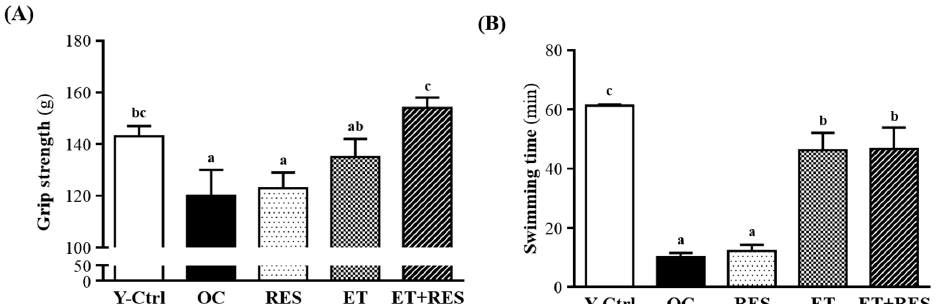
Figure 1. Effect of a 4-week resveratrol (RES) supplementation and exercise training (ET) on ( A ) forelimb grip strength and ( B ) endurance swimming performance in mice. Mice were pretreated with the vehicle, RES, ET, and ET+RES for 28 days. Data are the mean ± SEM. Different letters indicate a significant difference at p < 0.05 according to a one-way ANOVA. Y-Ctrl, a young control group; OC, an older control; RES, a supplementation with RES group; ET, a ET group; ET+RES, a combination of ET and RES supplementation group.